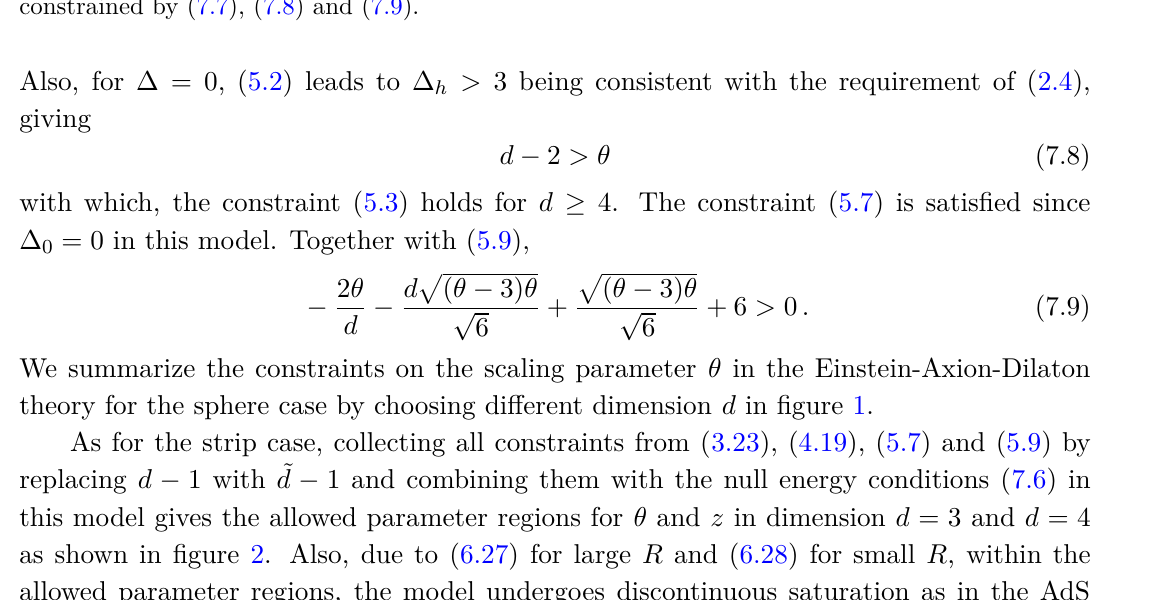
Figure 1 . The allowed regions of θ by fixing z = 1 in the sphere case in different dimension d , constrained by (7.7), (7.8) and